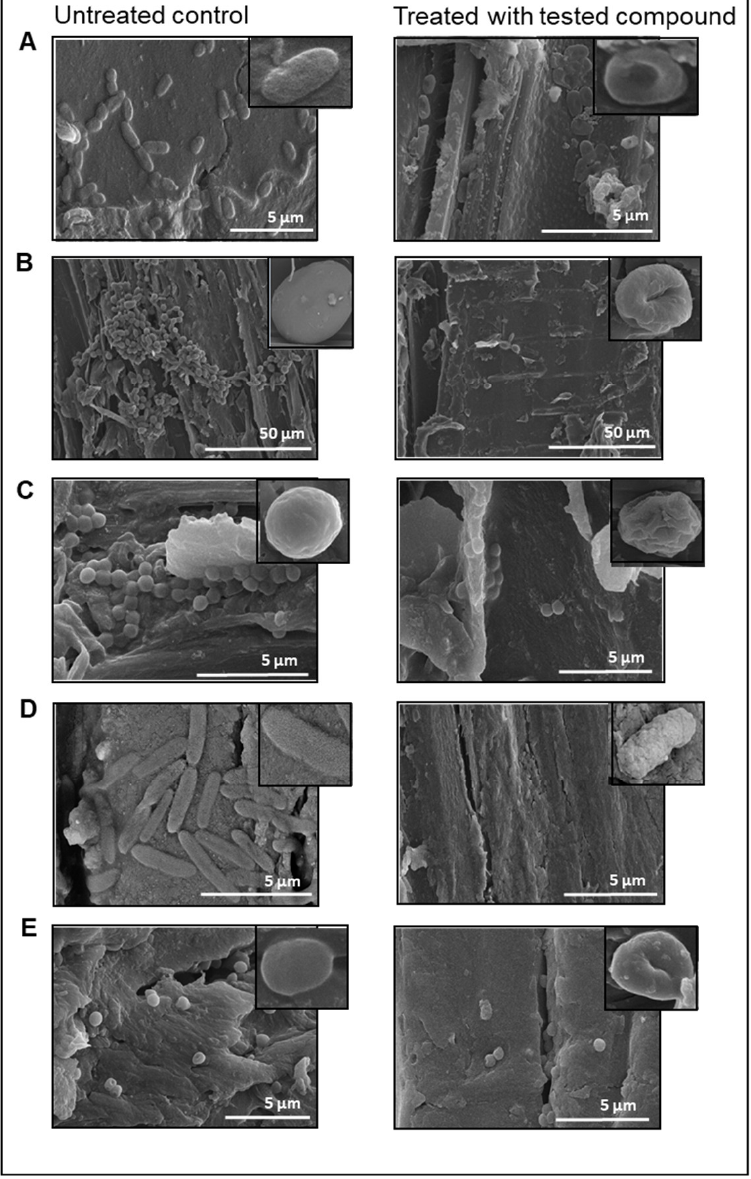
Figure 3. SEM images of untreated biofilms and biofilms treated with ( A ) P. aeruginosa , ( B ) C. albicans , ( C ) S. aureus , ( D ) E. coli , ( E ) S. epidermidis . Images represent typical fields of view.